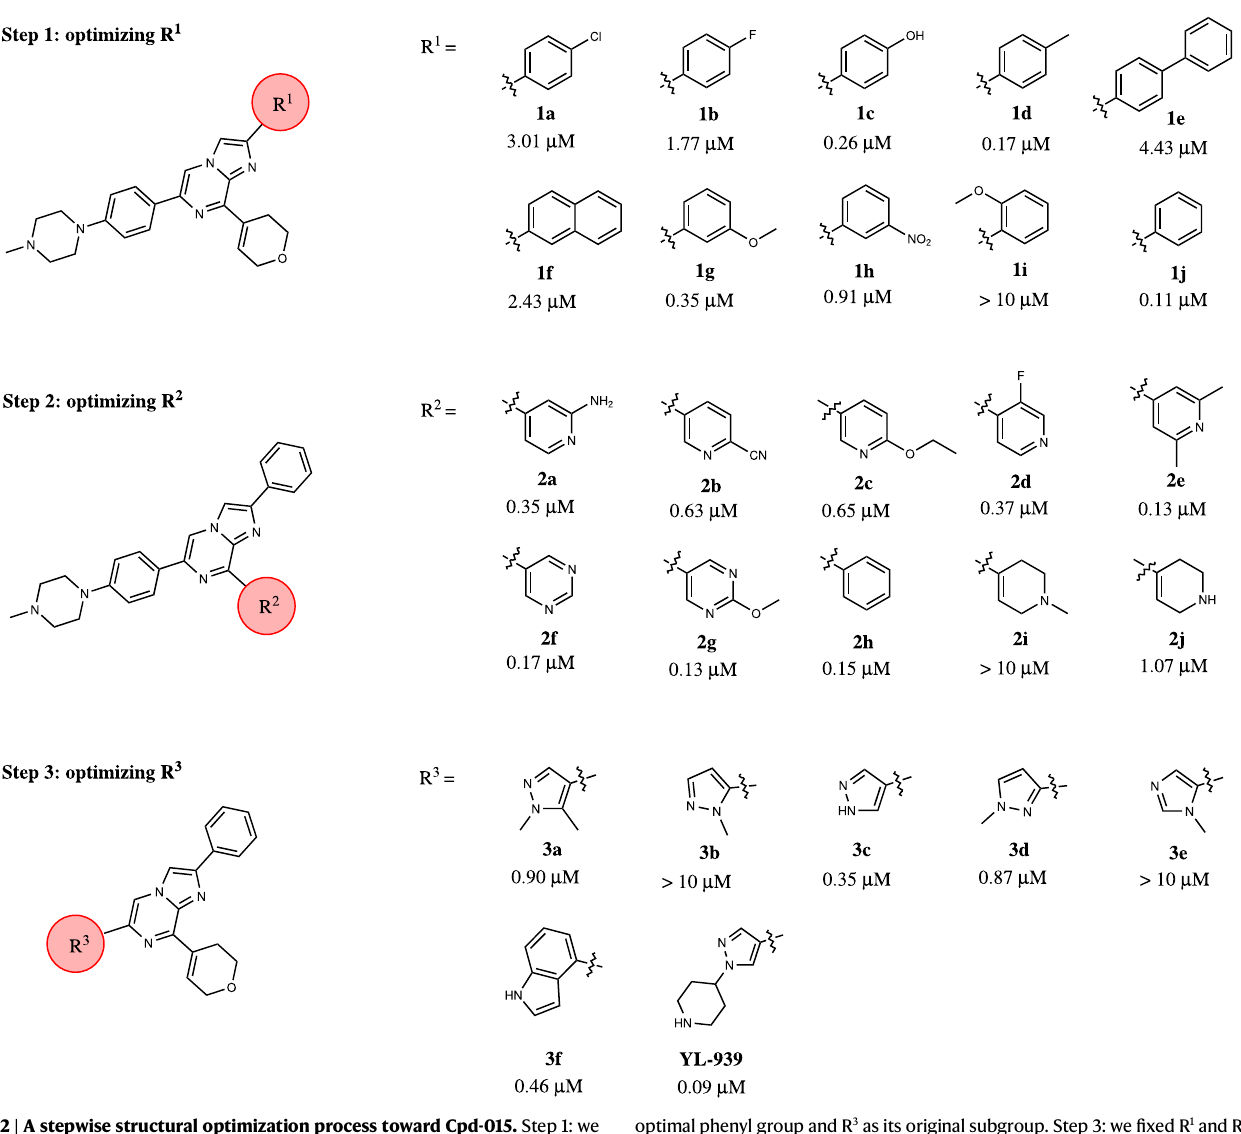
Fig. 2 | A stepwise structural optimization process toward Cpd-015. Step 1: we fi xed R 2 and R 3 and optimized R 1 . Step 2: we optimized R 2 with R 1 fi xed as the